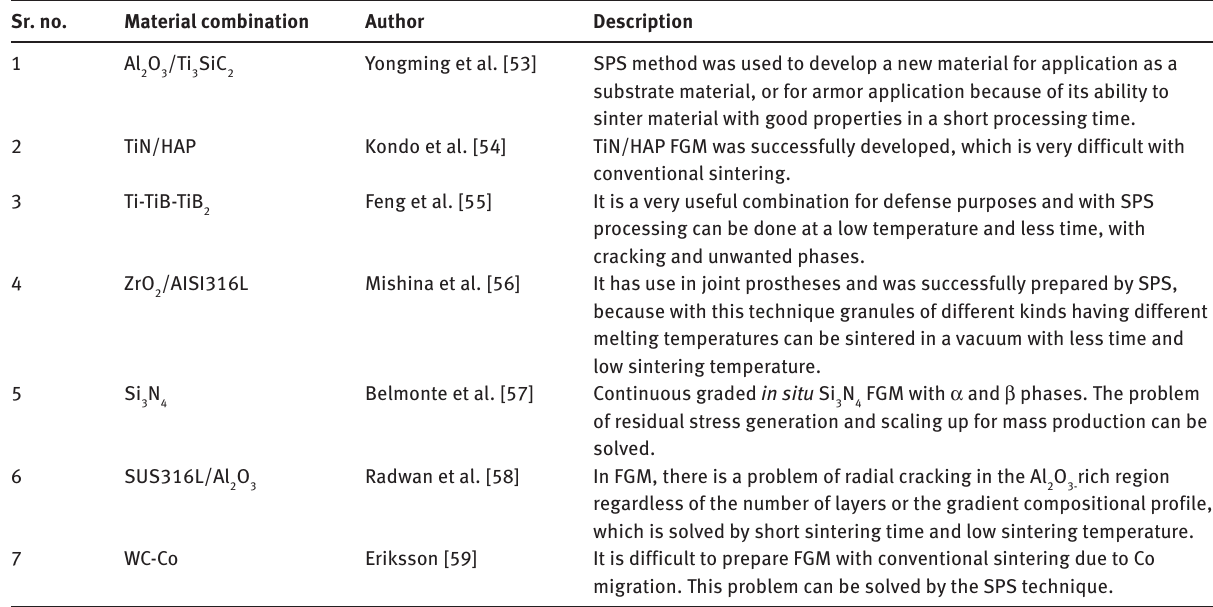
Table 5: List of different authors who used SPS for fabrication of FGM. Sr. no.